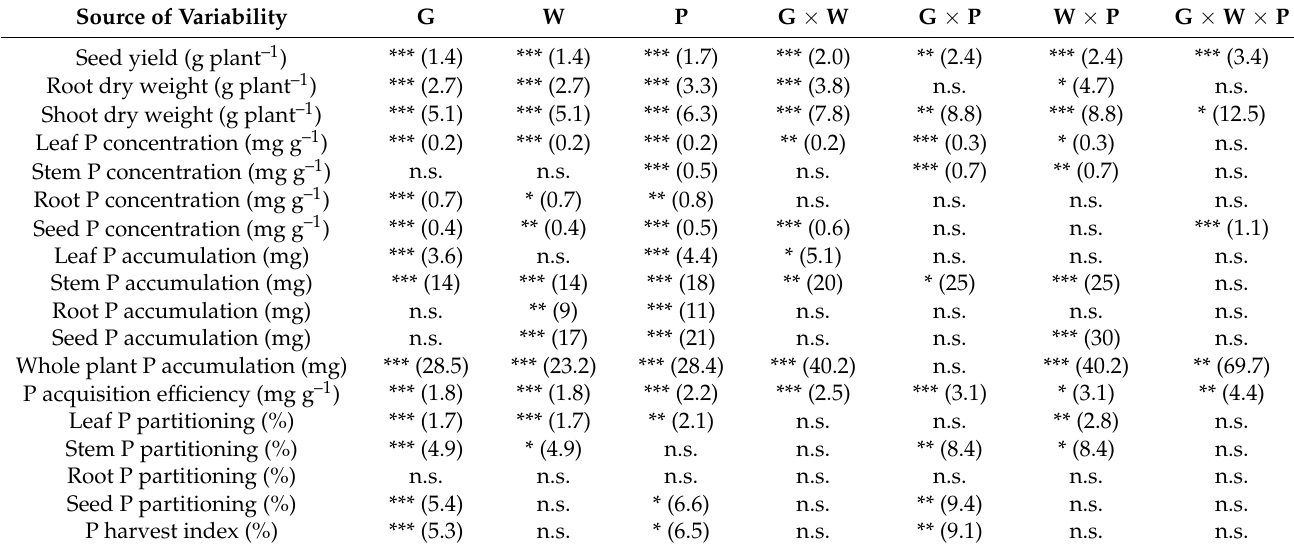
Table 1. Significance of sources of variability for genotypes (G), phosphorus levels (P), water treatments (W), and their interactions in Huangsedadou (HD) and Zhonghuang 30 (ZH) under two water regimes (well-watered (WW) and cyclic water stress (WS)) and three P rates (0 (P0), 60 (P60), and 120 (P120) mg P kg –1 dry